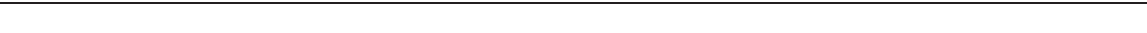
Fig. 1 Ensa KD strongly delays cells in S phase. a HeLa cells were treated with scramble siRNA (siSC) or Ensa siRNA#1 (siEnsa1) or #2 (siEnsa2) for 48 h. a Ensa levels and, as a loading control, β -tubulin( β Tub) were checked in these cells by immunoblot. b Ensa-GFP was overexpressed in control cells (parental or transfected with siSC) and in cells knocked down of Ensa with siEnsa1 and GFP fl uorescence intensity was analysed by FACS. c GFP levels in b were quanti fi ed by densitometry using ImageJ and represented as % of fl uorescence towards GFP levels on parental cells. d HeLa cells, treated with SC siRNA (siSC) or siEnsa1 or siEnsa2, were stained with propidium iodide and analysed by FACS. DNA content ( x -axis, propidium iodide) is represented towards the relative number of cells ( y -axis, counts). Coloured panel represents a merge of all conditions. The quanti fi cation of % of total cells in SubG1, G1, S and G2/M phases in each cell type is represented as a bar histogram . e As for d except that U2OS instead of HeLa cells where used. f Endogenous Ensa levels in U2OS treated with siSC and siEnsa1 were analysed by western blot and shown. g Cells treated with control SC siRNA ( left ) or siEnsa1 ( right ) were incubated in the presence of BrdU for 30 min at 48 h post transfection and analysed by bivariate FACS. Intensity of BrdU incorporation and DNA content was analysed by using anti-BrdU antibodies and 7-AAD staining, respectively. Boxed area indicates the percentage of cells in S phase (incorporating BrdU), and in G1 (2n DNA content non incorporating BrdU) or G2/M (4n DNA content) phases (Flow Jo analysis). h Cells treated with siSC or siEnsa1 or siEnsa2 were incubated in presence of EdU for 60 min at 48 h post transfection and incorporated EdU was subsequently detected by Click-iT reagent. Scale bar , 5 μ m. i The percentage of EdU-positive cells towards the total cell number (determined by differential interferene contrast microscopy (DIC)) in each condition was represented as a bar graph of the mean value ± standard